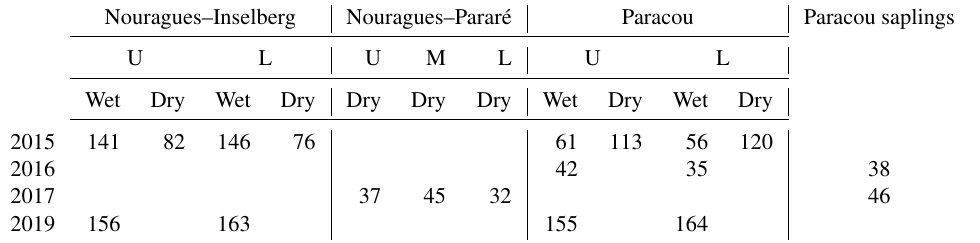
protocol 2.1.6 “Foliar nutrient stoichiometry and